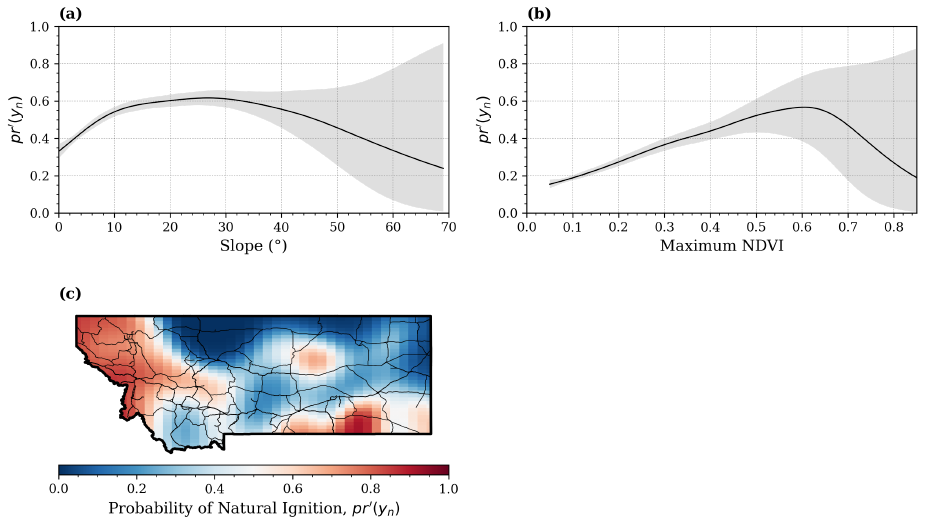
Figure 7. Partial effects plots for slope ( a ), maximum NDVI ( b ) and longitude and latitude ( c ) included in the spatial-GAM built to predict the probability of a naturally ignited wildfire, pr ( y n )